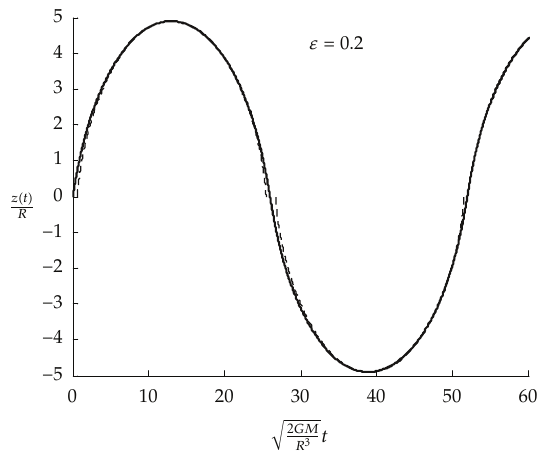
Figure 2: The function z (cid:4) t (cid:5) with ε (cid:7) 0 . 2, the solid line corresponds to numerical integration of (cid:4) 3.1 (cid:5) , the dashed line represents the outer solution (cid:4) 3.31 (cid:5)